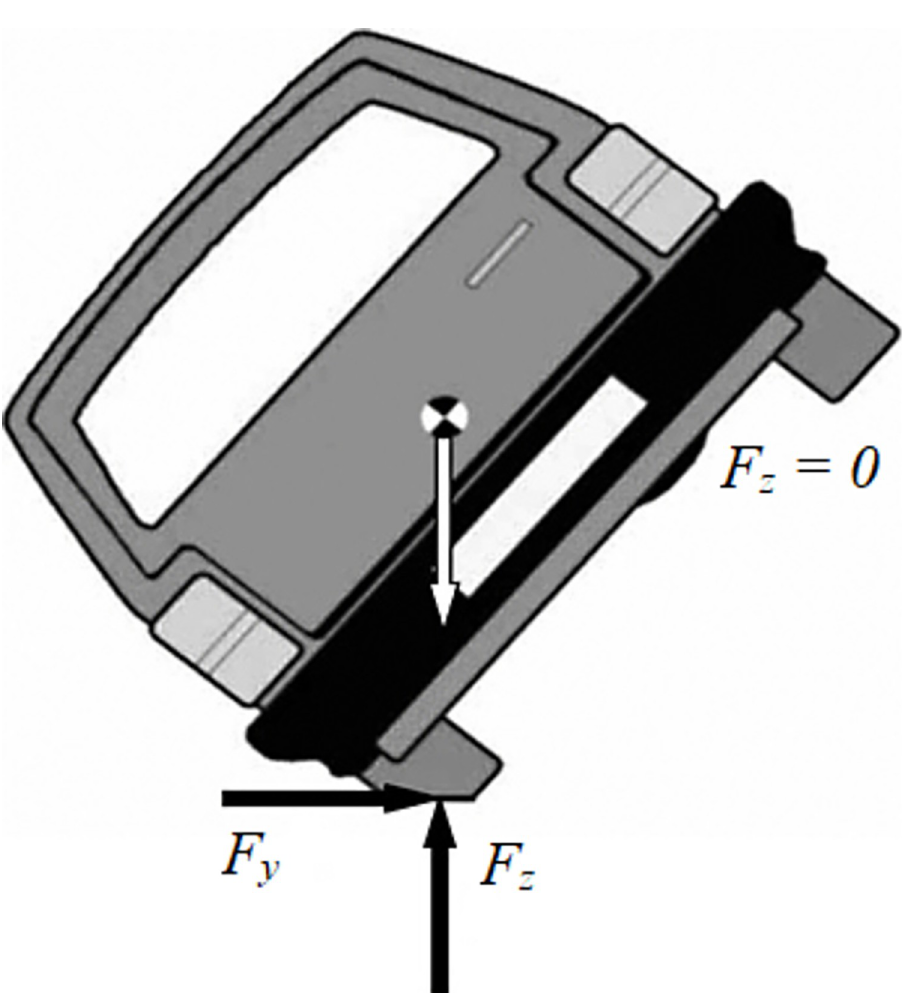
Fig 1. A vehicle rollover stability assessment